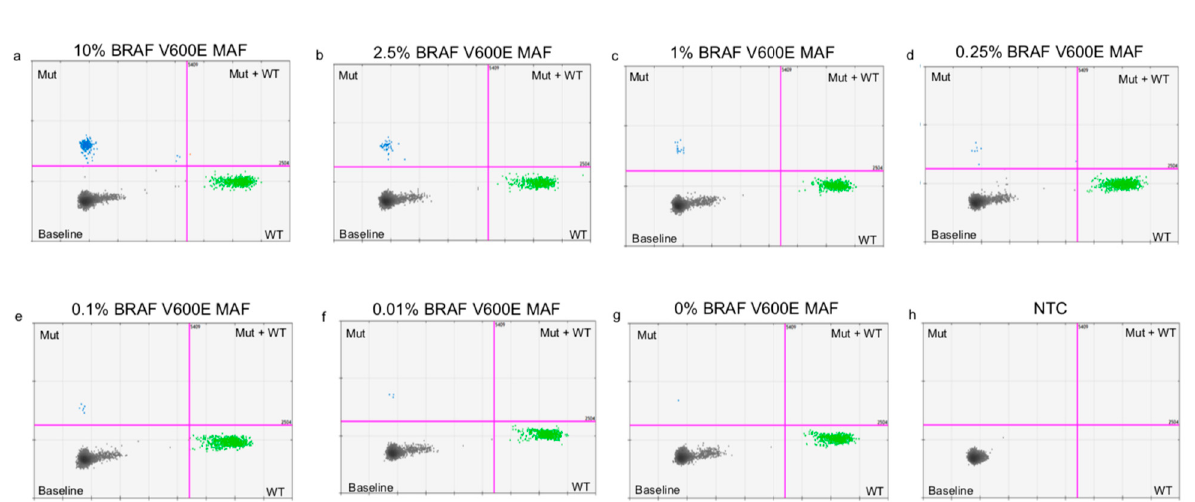
Figure A2. ddPCR 2D Plots of BRAF V600E serial dilutions in a constant background of BRAF WT. Plots of wild type channel amplitude ( x -axis) and mutant channel amplitude ( y -axis) of serial dilutions of BRAF V600E from Yumel 0106 cell lines in decreasing concentration from 10% MAF ( a ), 2.5% ( b ), 1% ( c ), 0.25% ( d ), 0.1% ( e ), 0.01% ( f ), to 0% MAF ( g ) into a background of BRAF WT from HBMVEC cell lines. The no template control (NTC) is also shown ( h ).